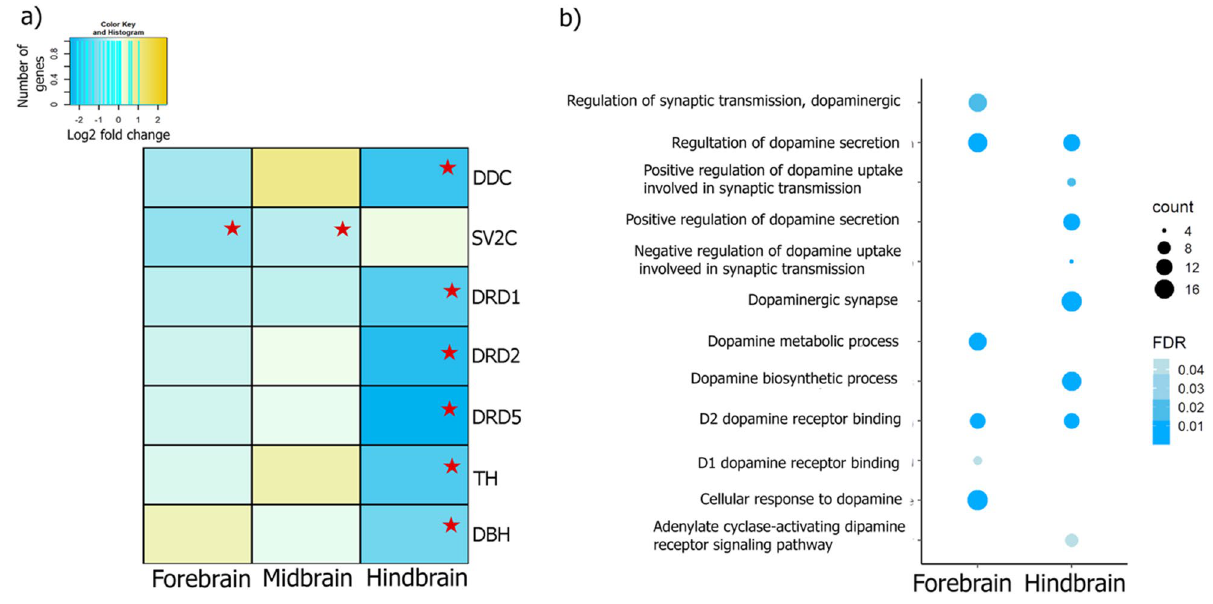
Figure 3. ( a ) Dopaminergic pathway differential gene expression in the three brain regions of L. dimidiatus . The colours presented correspond to log2fold changes. The red star represents significance. The legend indicates the reference values of log2fold changes for each DEG in the figure. ( b ) Functional enrichment of Gene Ontology (GO) terms related to Dopamine activity in L. dimidiatus in the Fore and Hindbrain. No enrichment was found for the Midbrain region. The size of the circles is proportional to the number of genes observed within each GO category, and the colour of the circles is proportional to the significance (FDR value).